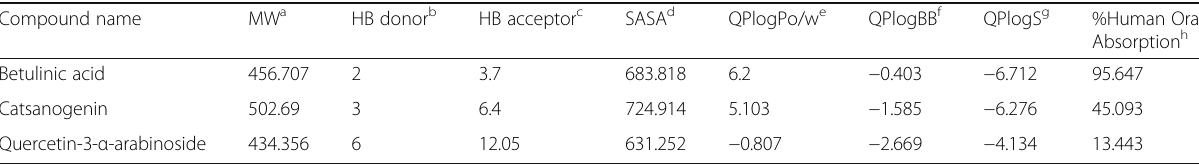
Table 8 ADME and drug likeness properties of betulinic acid, quercetin-3- α -arabinoside and catsanogenin by QikProp Compound